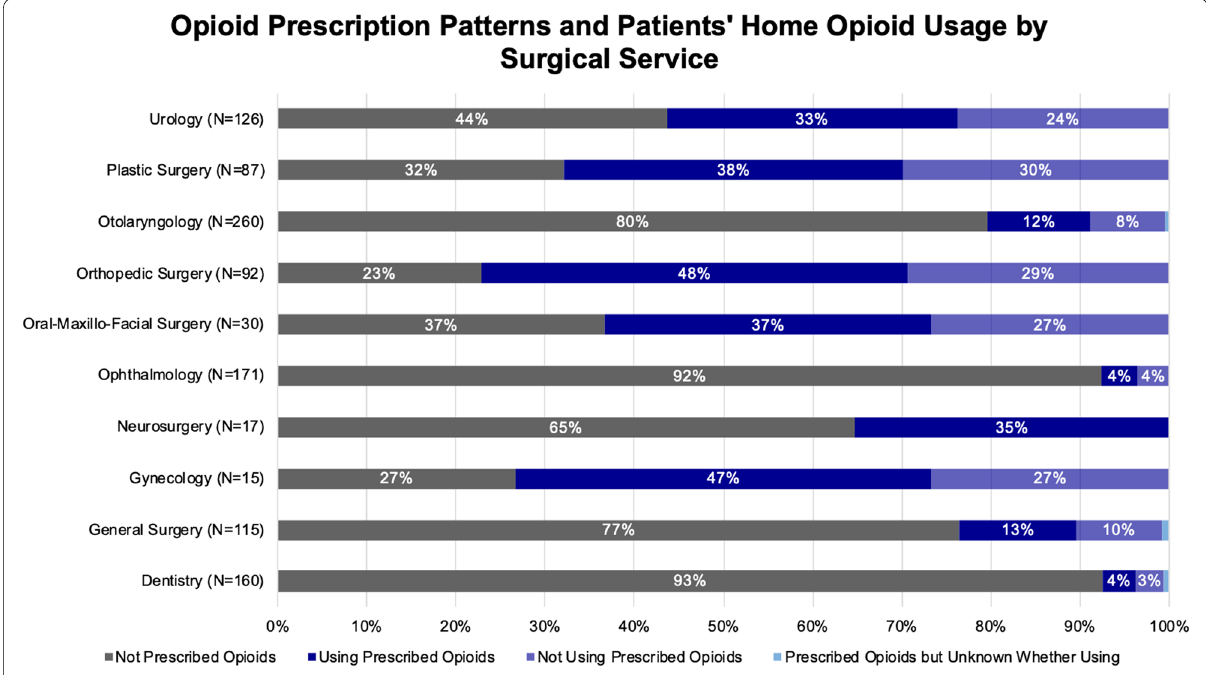
Fig. 1 Opioid prescription patterns and patients’ home opioid usage by surgical